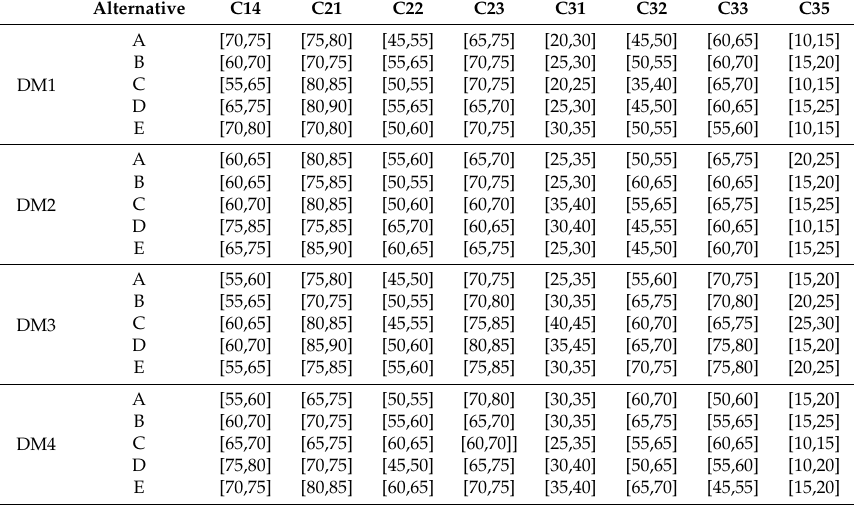
Table 10. The data of the qualitative criteria with respect to the barrages A-E in the Severn estuary.